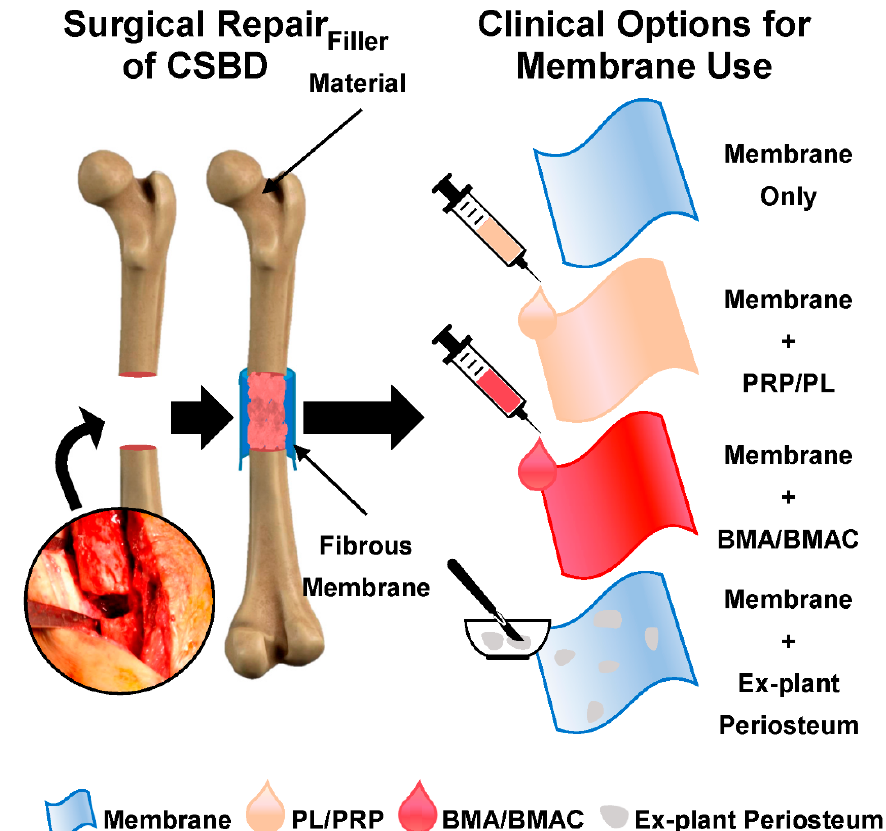
Figure 6. Schematic for surgical repair of CSBDs, with use of barrier membrane to wrap around the defect site, containing grafting material. The membrane can be used on its own or in combination with various blood products and MSC sources, dependent on the clinical need. PRP—platelet rich plasma PL—platelet lysate, BMA—bone marrow aspirate, BMA—BMA concentrate.